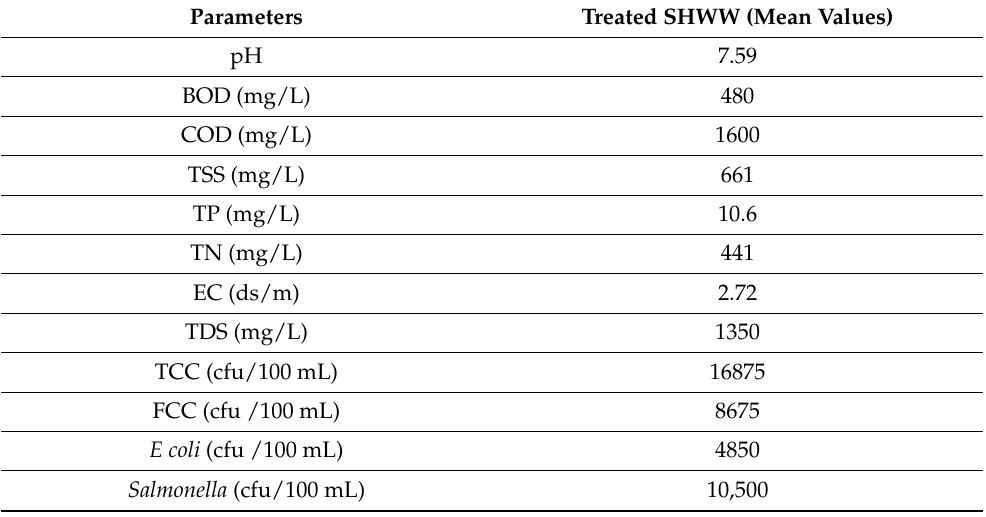
Table 1. Characteristics of the SHWW under examination in the experiment.